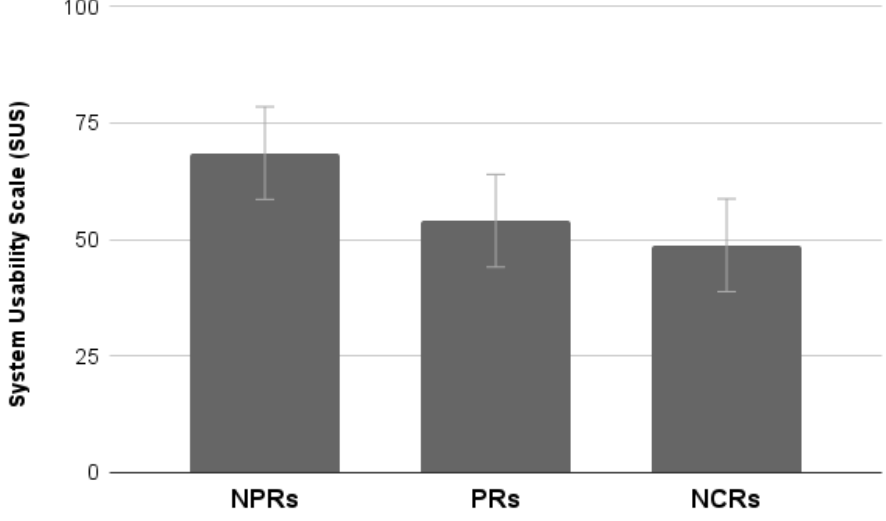
Figure 17. SUS score by Group (NPRs vs. PRs vs. NCRs). Error bars denote 0.95 confidence intervals.